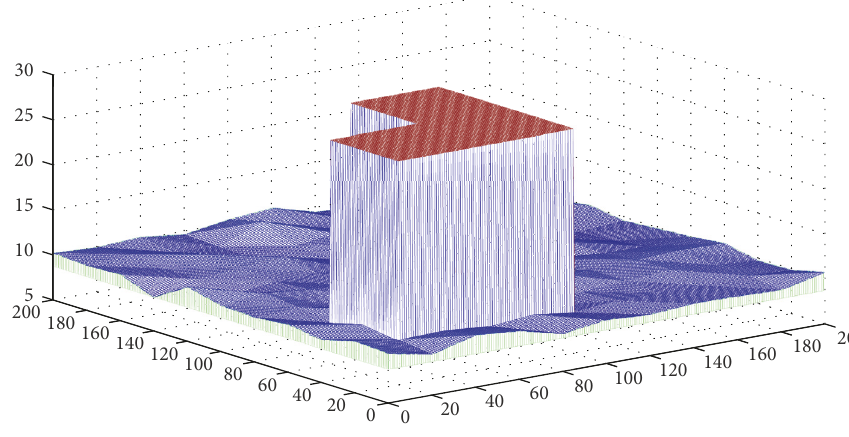
Figure 9: Original terrain.